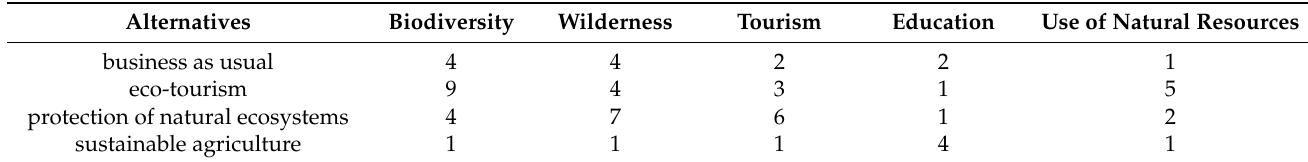
Table 7. Preference relation for the worst alternative (others to the worst).